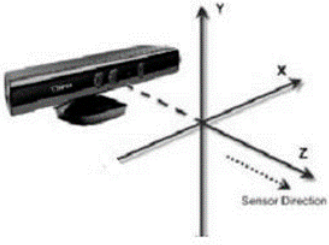
Figure 1. Kinect coordinate system.